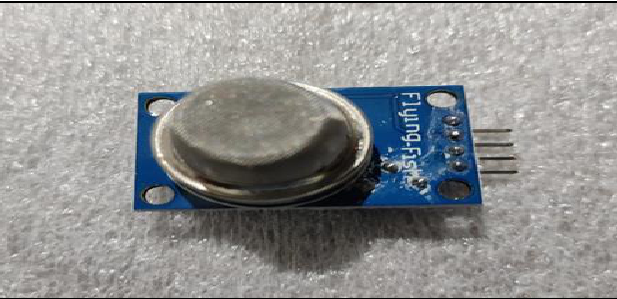
Figure: The MQ5 Gas sensor.